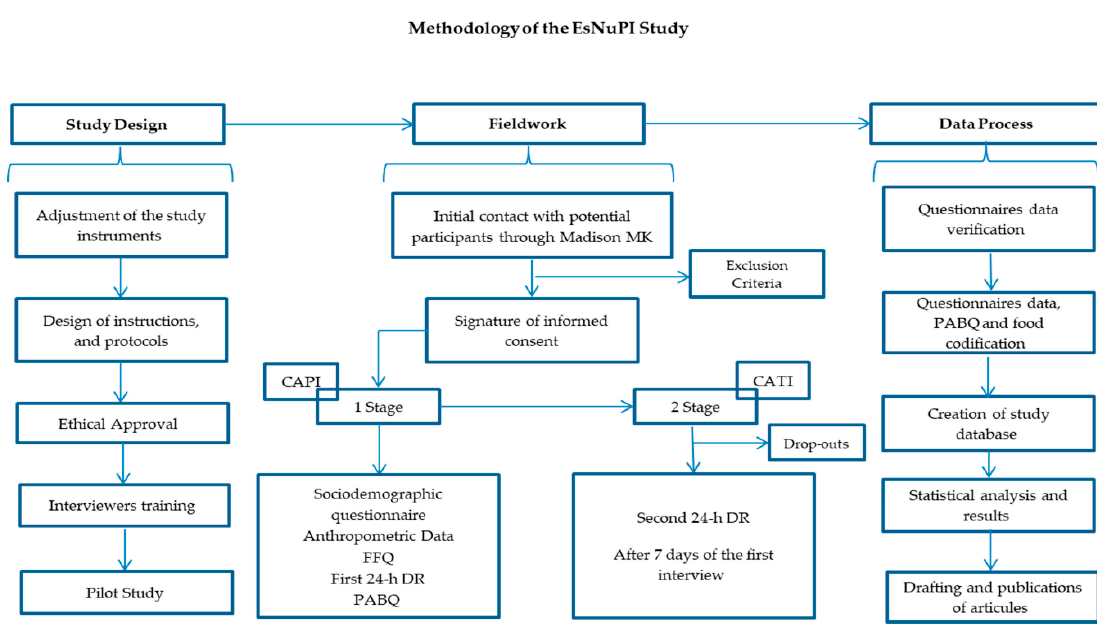
Figure 1. Design and methodology of the EsNuPI study. Taken from Madrigal et al., 2019 [15]. CAPI, Computer-Assisted Personal Interviewing; FFQ, food frequency questionnaire; 24-h DR, 24-h dietary recall; PABQ, physical activity and sedentary behaviors questionnaire; CATI, Computer-Assisted Telephone Interviewing.